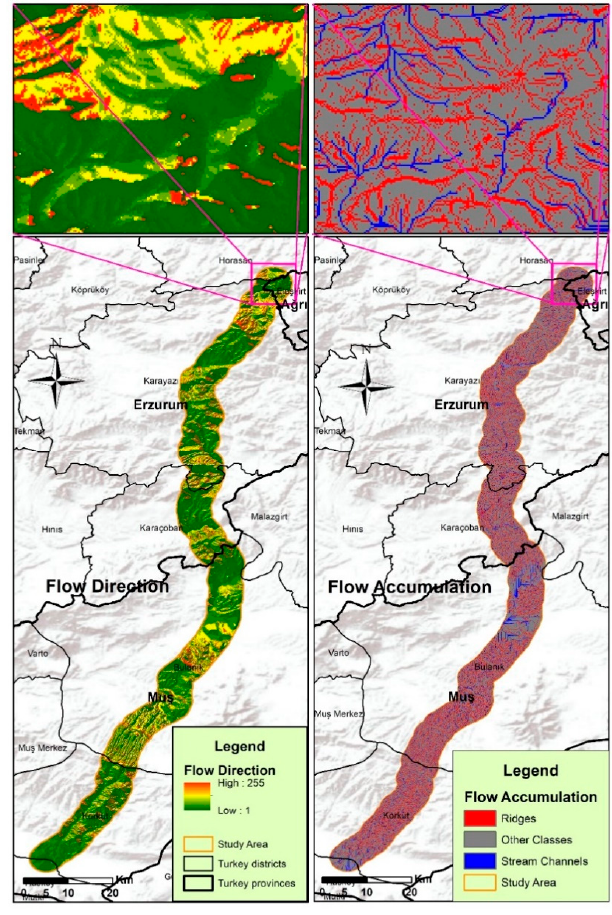
Figure 4. The results of flow direction (FD) and flow accumulation (FA).